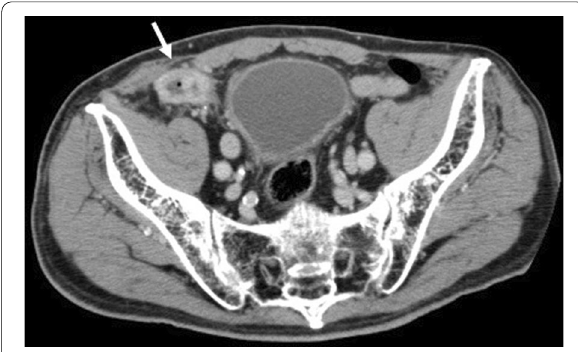
Fig. 1 Computed tomography (CT) findings upon admission. The CT scan demonstrates a peri-appendicular abscess